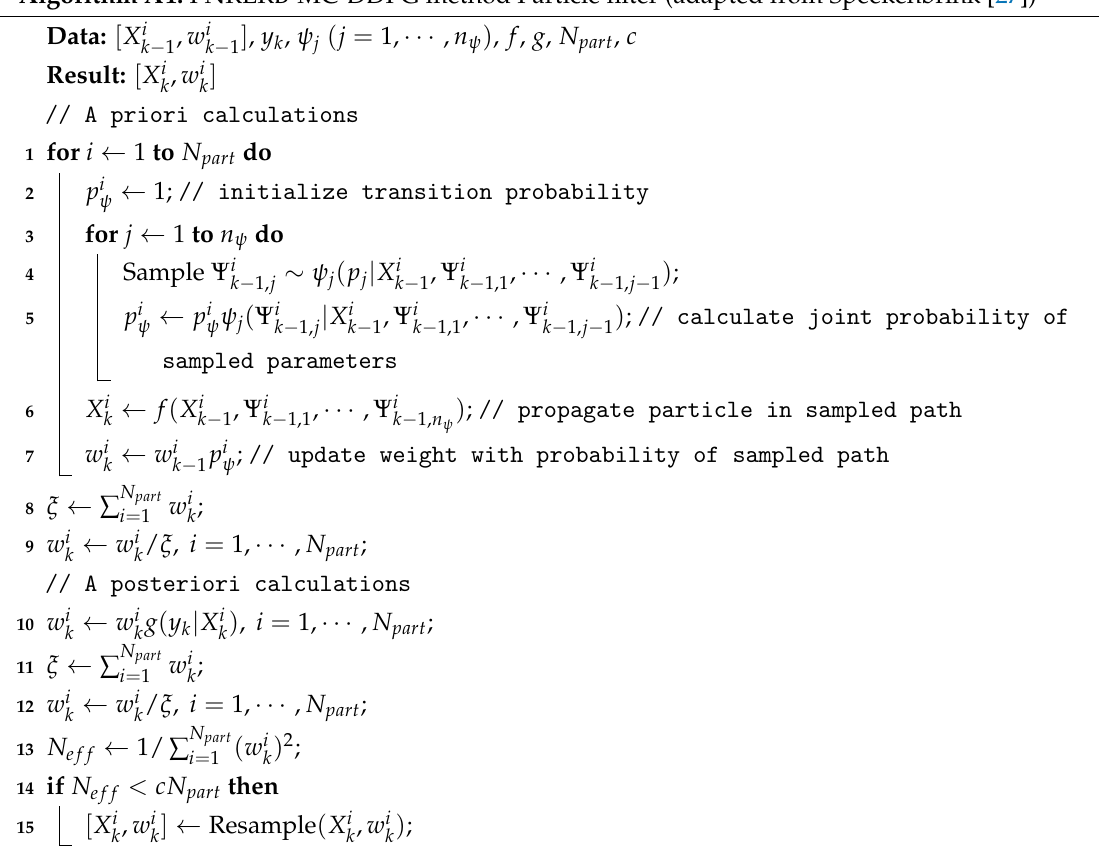
Algorithm A1: PNRERB-MC-DDPG method Particle filter (adapted from Speekenbrink